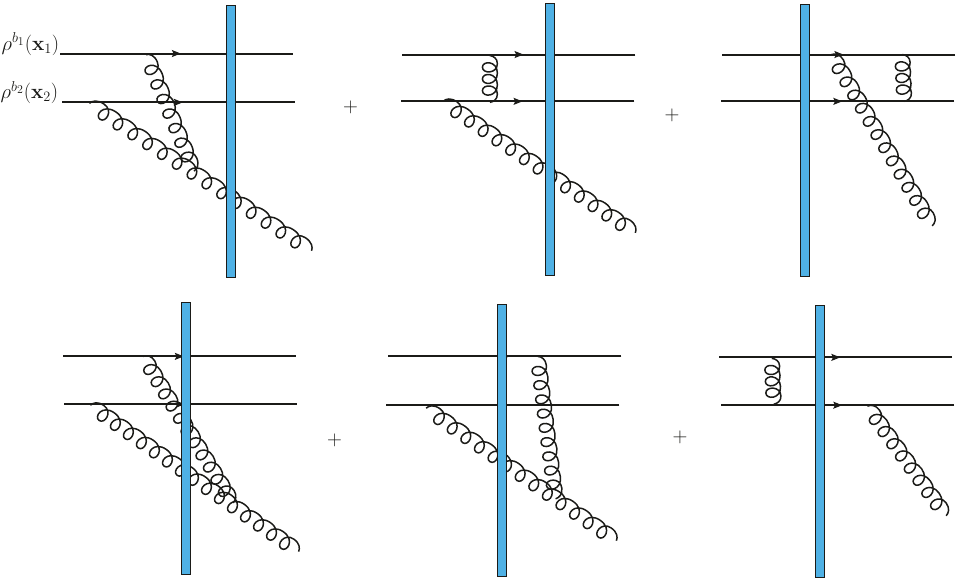
Figure 2 . Partial diagrams representing the order- g 3 single gluon production amplitude. It involves interactions of two color charge densities ρ b 1 ( x